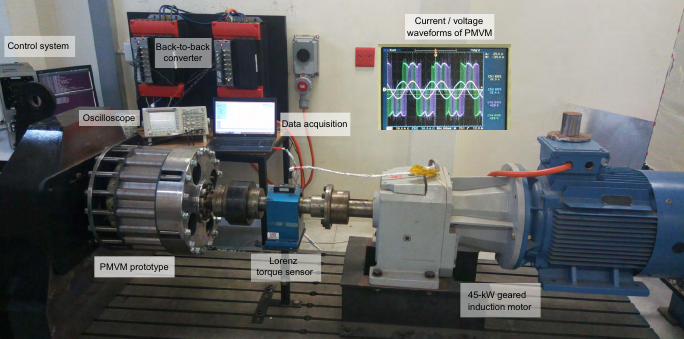
Figure 25. The laboratory test setup for the PMVM prototype